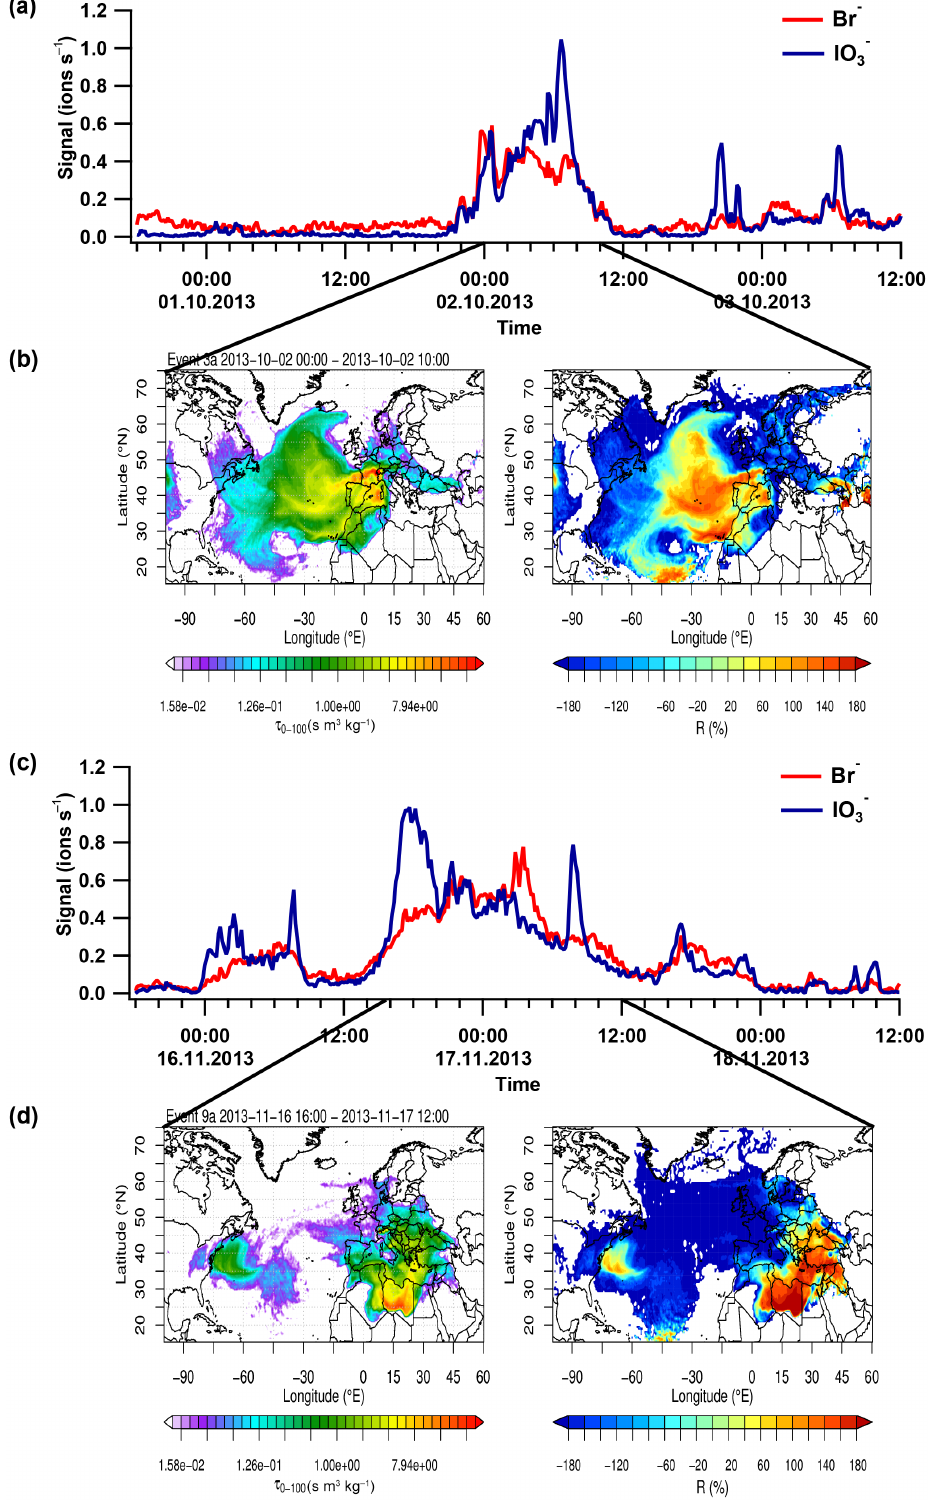
Figure 7. Examples of two events with high Br − and IO − signal and back trajectories for surface residence time. (a, b) Air masses from the 3 Atlantic, (c, d) air masses from the Mediterranean. The black lines denote the time period for the trajectory analyses shown in (b) and (d)